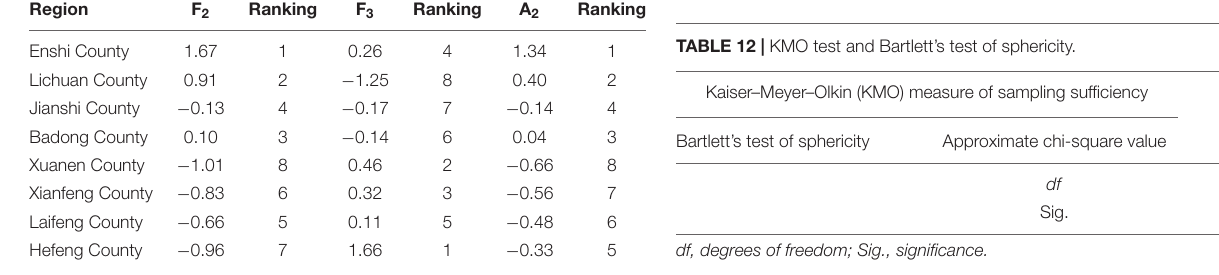
TABLE 11 | Scores and rankings of EAP’s economic environment’s competitiveness (A 2 ). Region